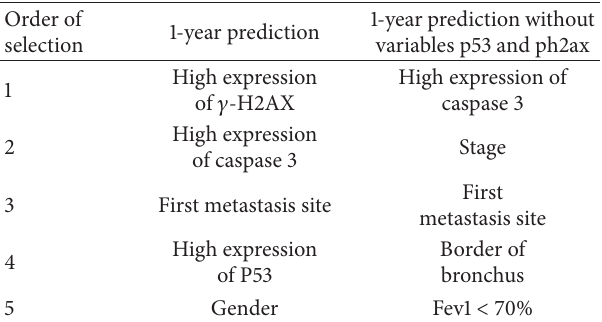
Table 4: Selected input variables by the parameter-increasing method.